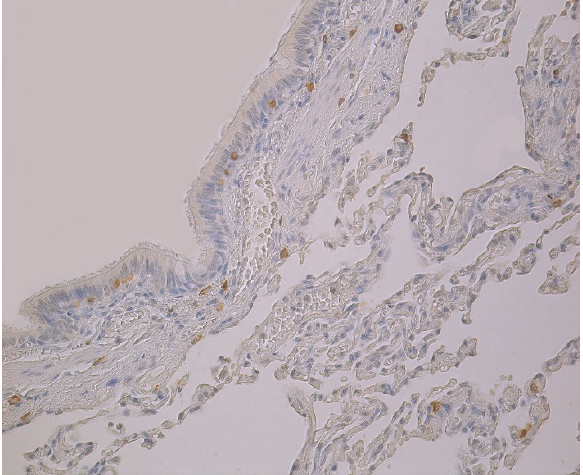
Figure 2. Note a few HBD-3 positive cells in the bronchial and alveolar epithelium, and in connective tissue of 59-year-old female bronchial wall. HBD-3 IMH, ×200.